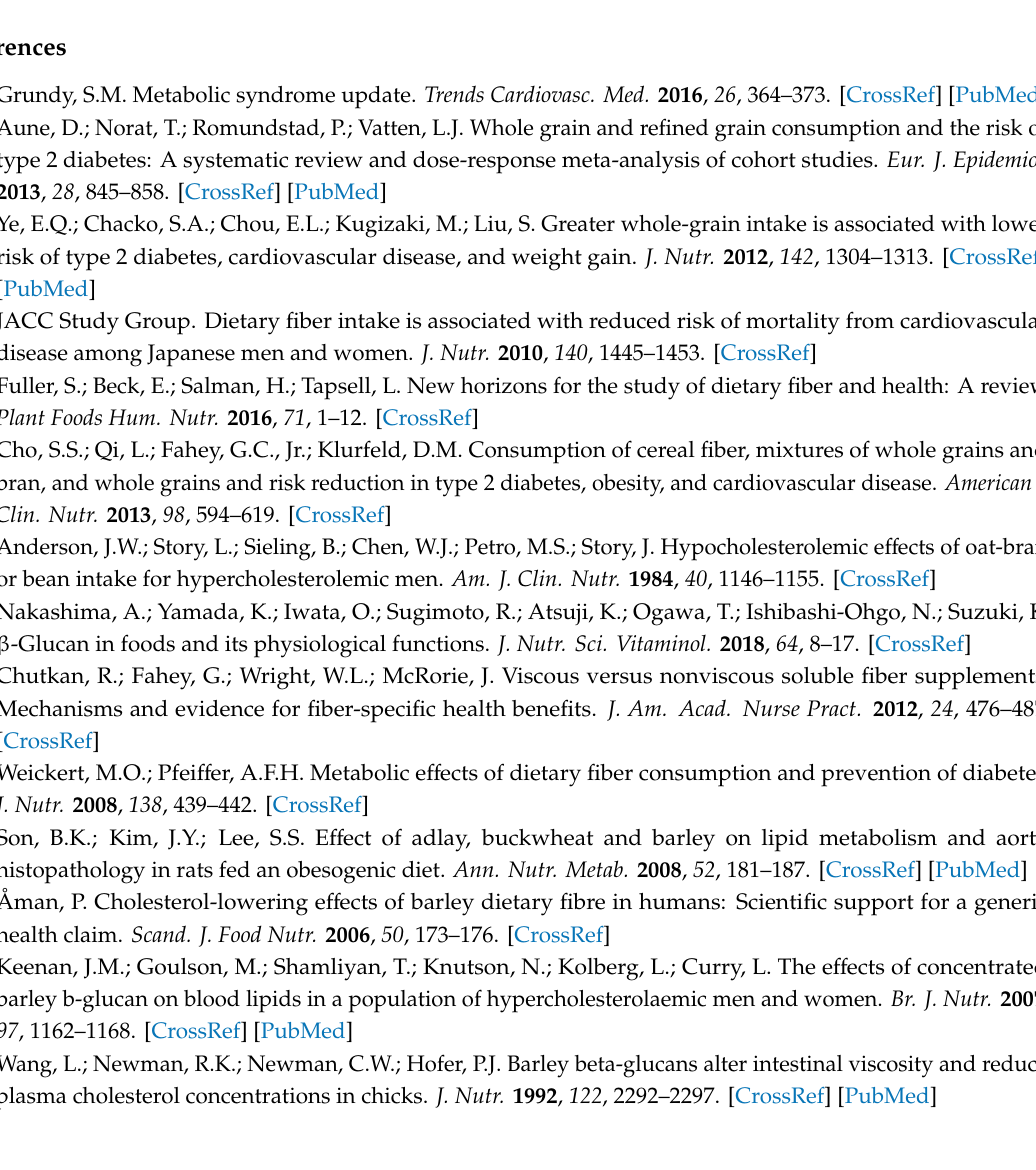
Table S1: Primers used in the real-time reverse transcription polymerase chain reaction. Table S2: Di ff erentially expressed genes in the ileum by microarray analysis. Table S3: Di ff erentially expressed genes in the liver by microarray analysis., Table S4: Di ff erentially expressed genes in the adipose tissue by microarray analysis. Author Contributions: Conceptualization, K.M. and S.A.; methodology, K.M. and S.A.; formal analysis, K.M.,